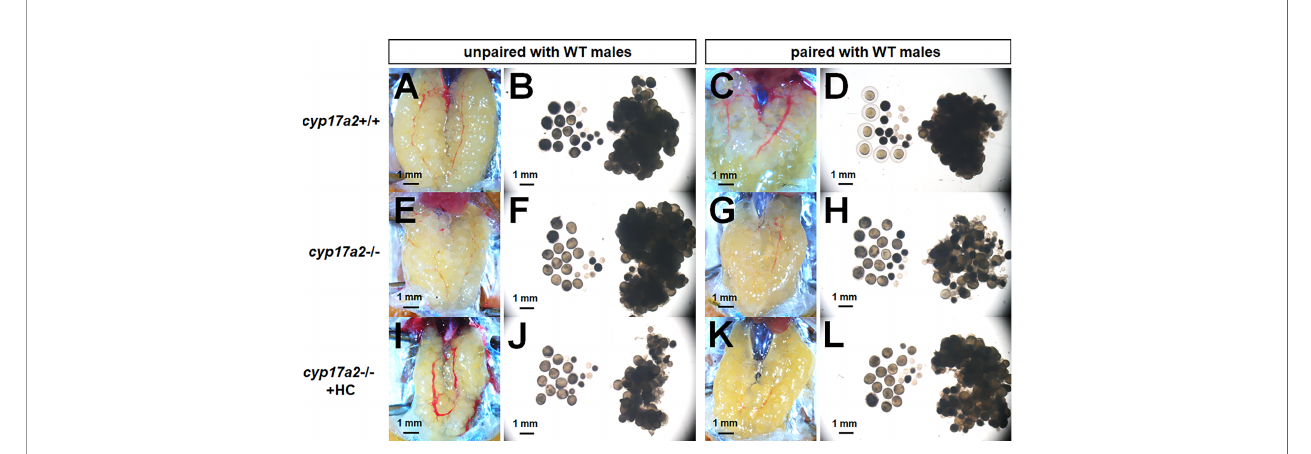
FIGURE 6 | The over-activated oocytes in cyp17a2 -/- females. (A – D) Under visual microscopy, the oocytes from control females unpaired and paired with WT males were not transparent and transparent, respectively (n = 5). (E – H) The oocytes from cyp17a2 -/- females unpaired and paired with WT males were both transparent (n = 5). (I – L) The 20 nM hydrocortisone treatment in cyp17a2 -/- females did not promotes oocyte maturation as observed under visual microscopy (n = 5).